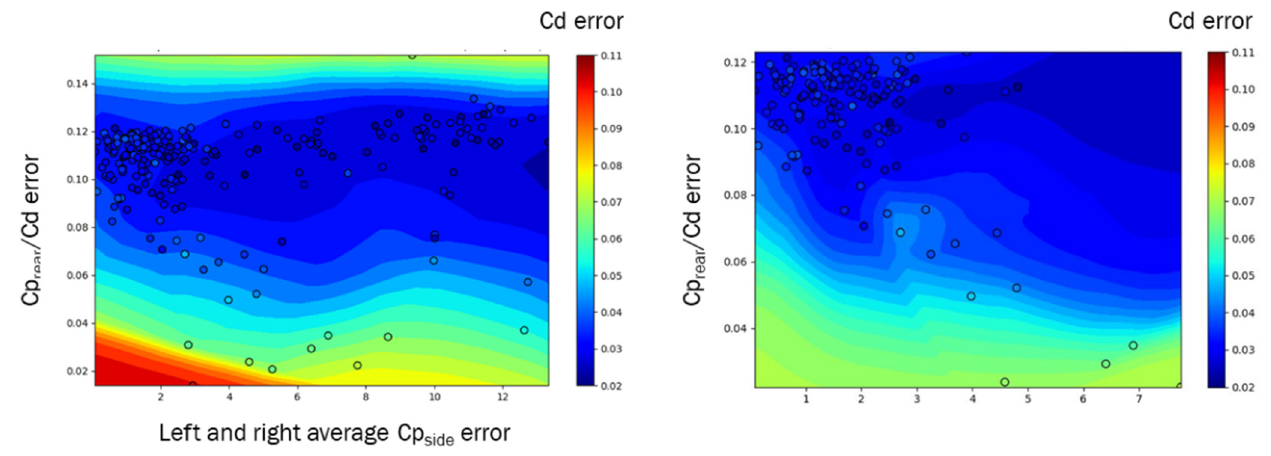
Figure 13. Cd objective versus rear pressure ratio and side pressure value for the Sobol and Dakota in left and Dakota only on the right.